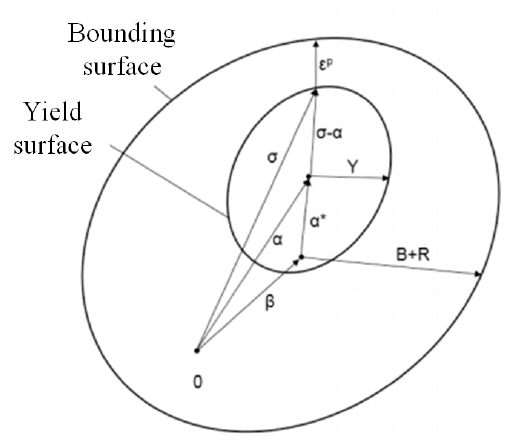
Figure 5. Schematic illustration of the Yoshida–Uemori model.